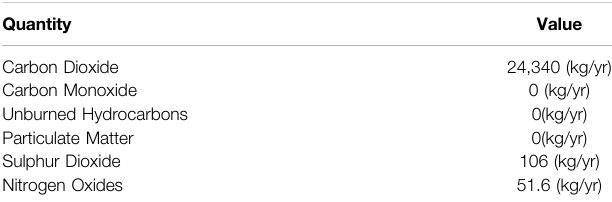
TABLE 8 | Emissions produced by HRES.